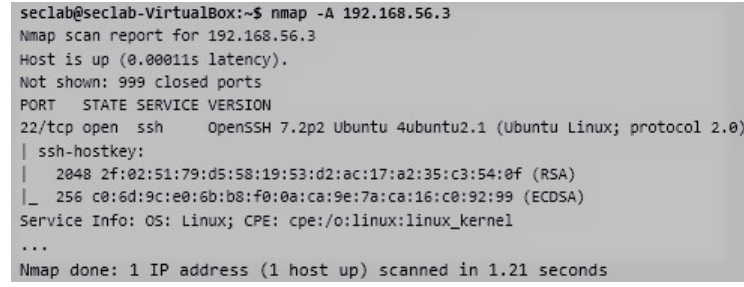
Figure 6. Obtaining of Port Services and Additional Information for a Network